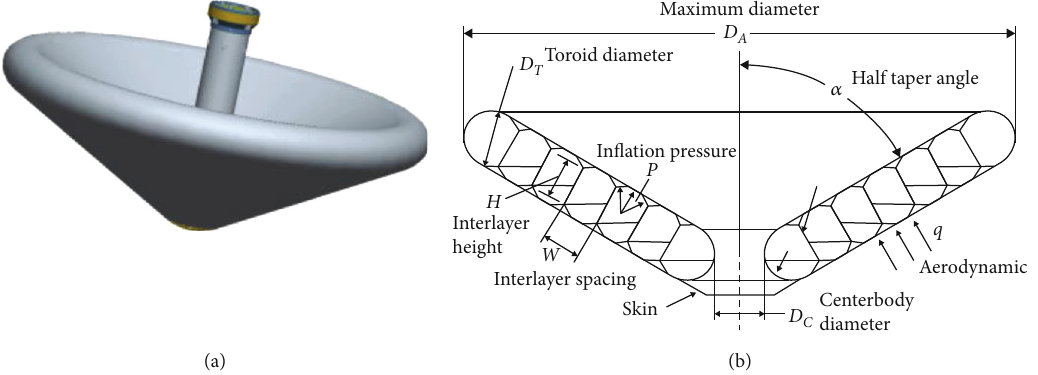
Figure 2: IRVE-3 system: (a) schematic diagram; (b) sectional view.